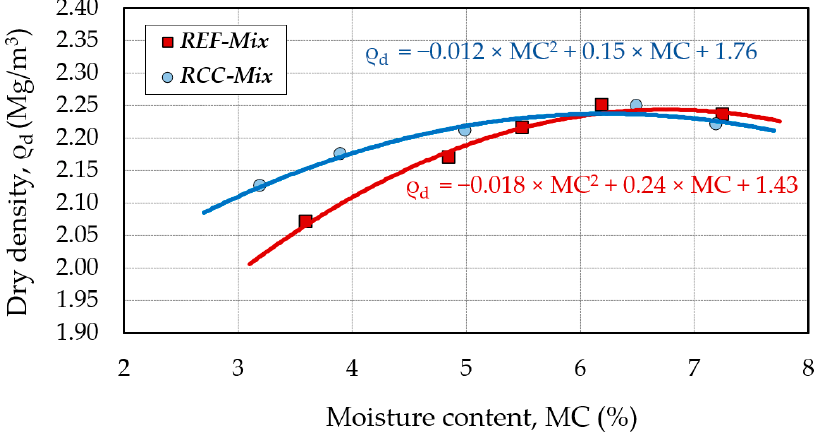
Figure 10. The relationship between moisture content (MC) and dry density ( ρ d ) for the tested mix- tures.